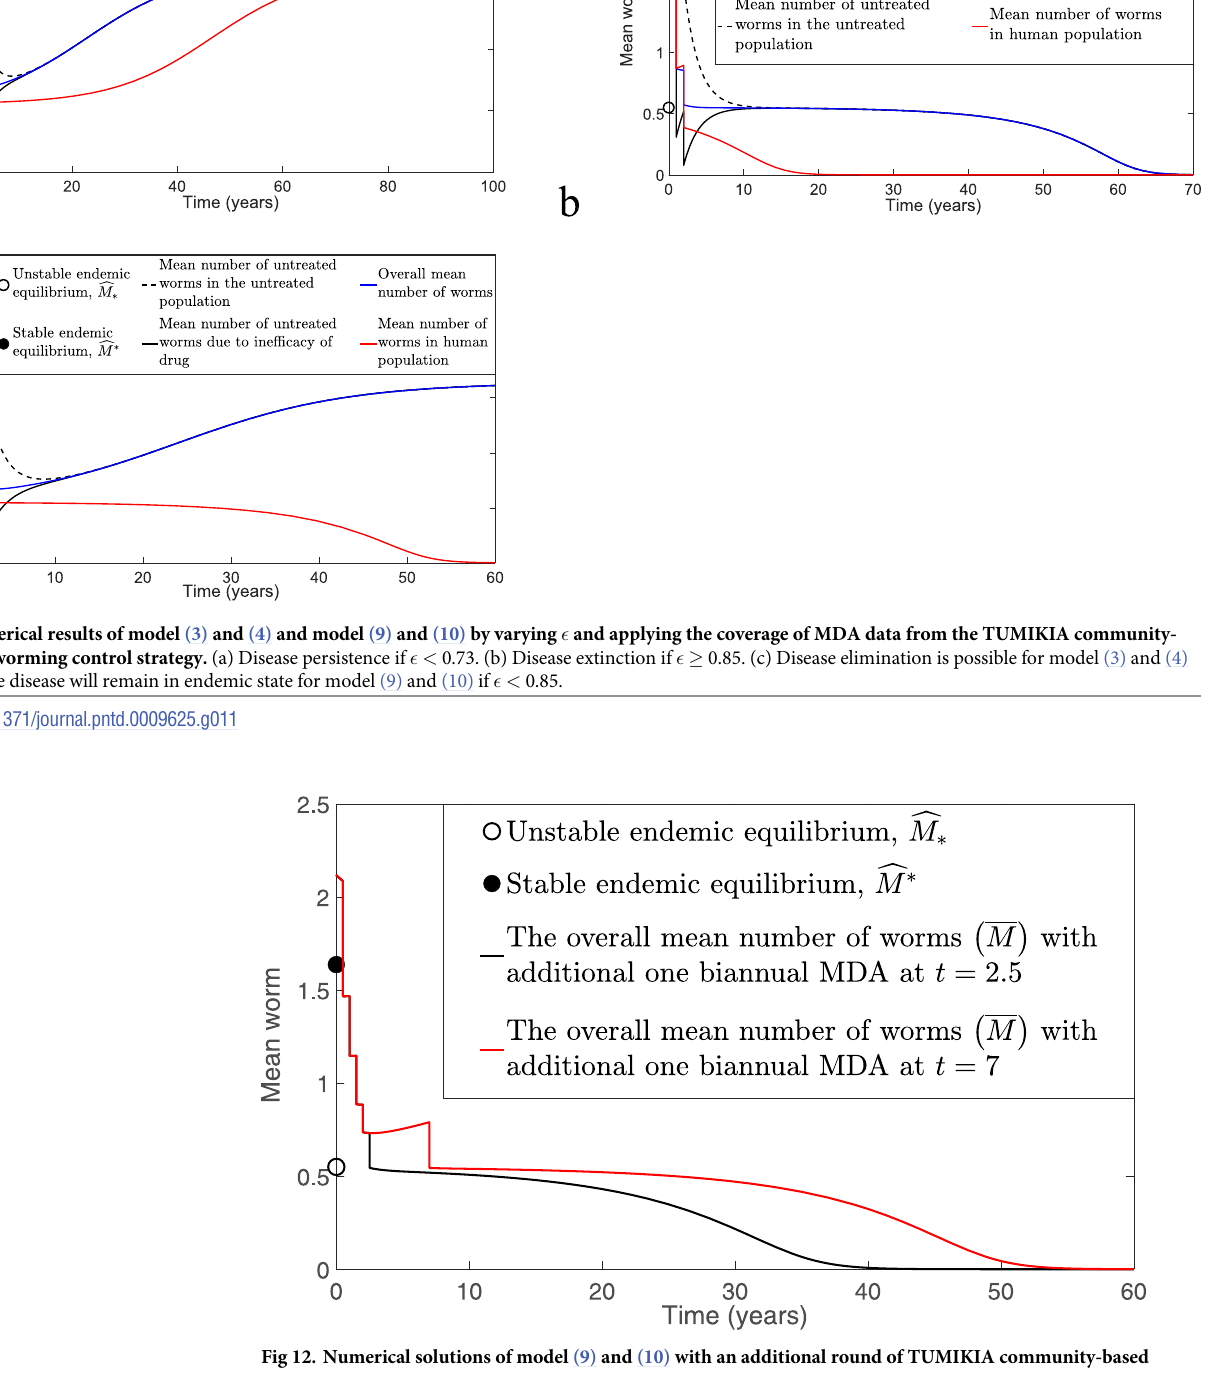
PLOS NeglectedTropical Diseases | https://doi.org/10.1371/journal.pntd.0009625 August 2, 2021 18 /